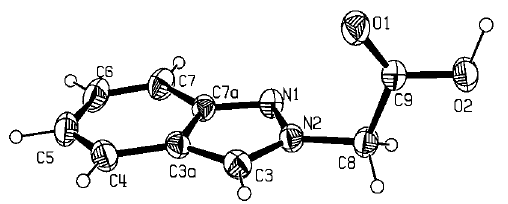
Figure 2. ORTEP [23] view of compound 5b showing the atomic labelling scheme and the relative positioning of the indazole ring and the carboxylic moiety.